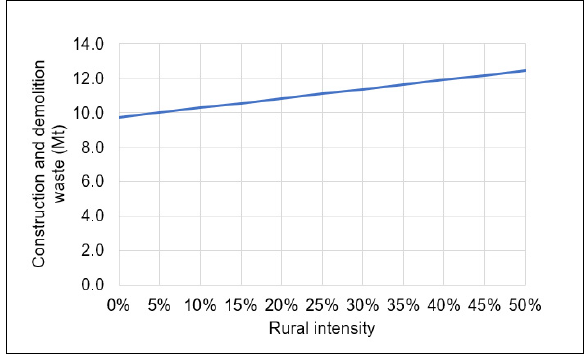
Figure 3: Sensitivity of the per-capita multiplier result to rural waste generation intensity.